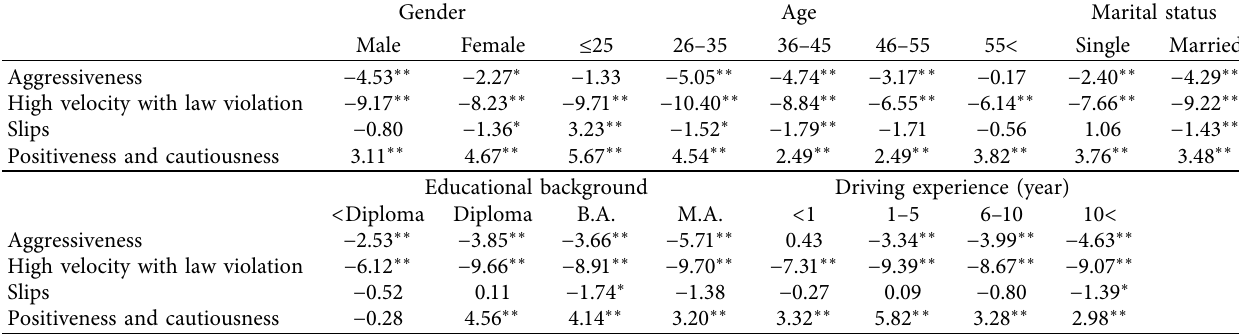
Table 4: Differences in driving behaviour from rainy conditions based on demographic